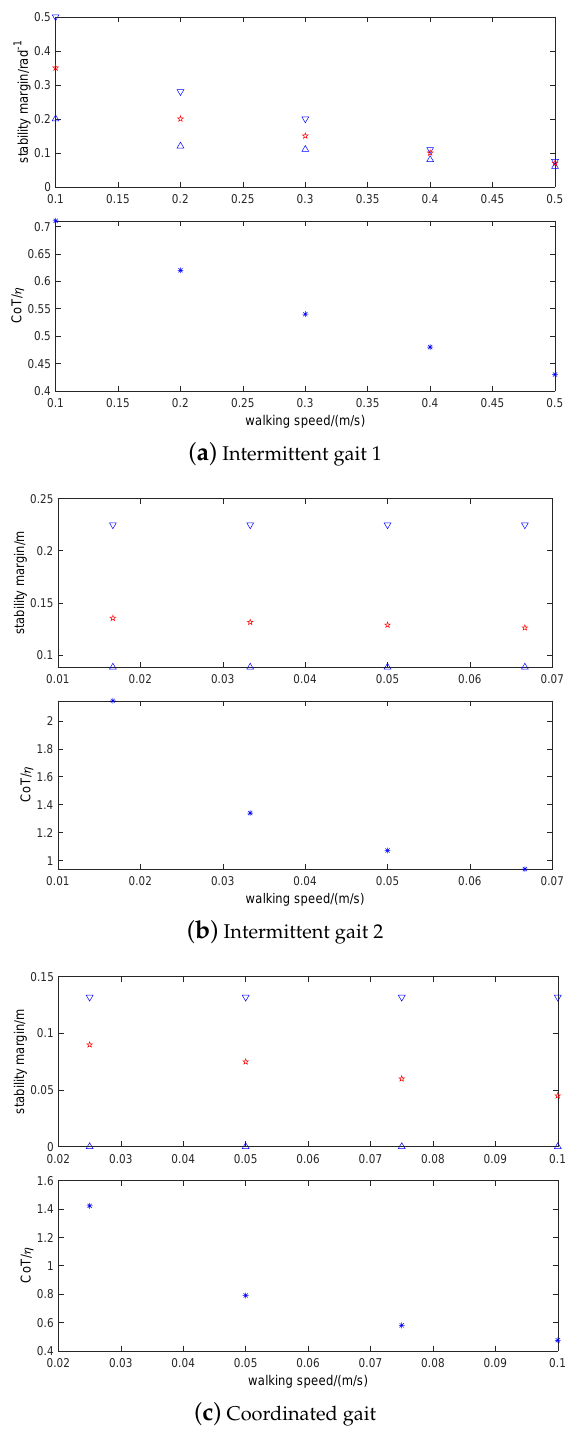
Figure 20. Relationship among walking speed, CoT and stability of three static gaits ( ∇ , ∆ & ∗ are upper and lower limits and mean values,